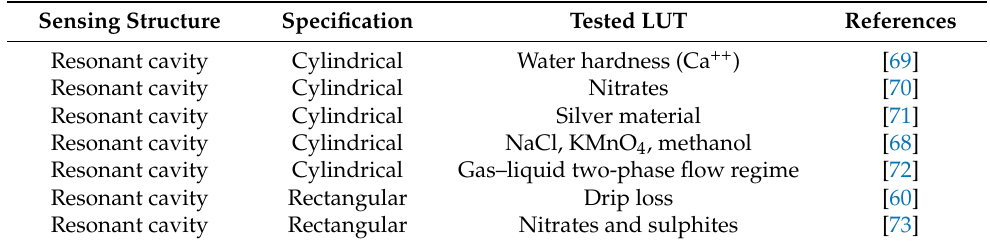
Table 2. Example of resonant cavities and their tested application for LUT measurements.